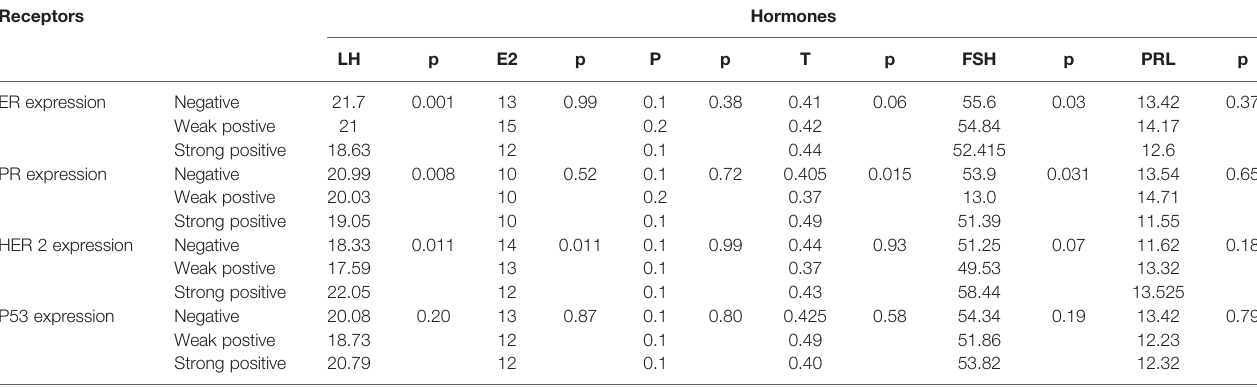
TABLE 4 | Association between hormones and hormone receptors. Receptors